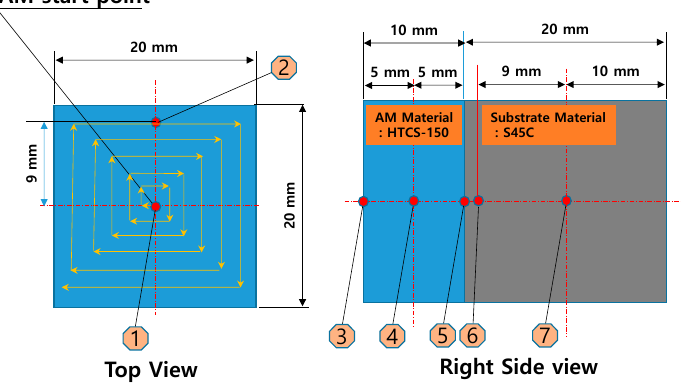
Figure 16. Schematic of AM process and measurement positions of residual stress. Table 10. Residual stress with different heating conditions.